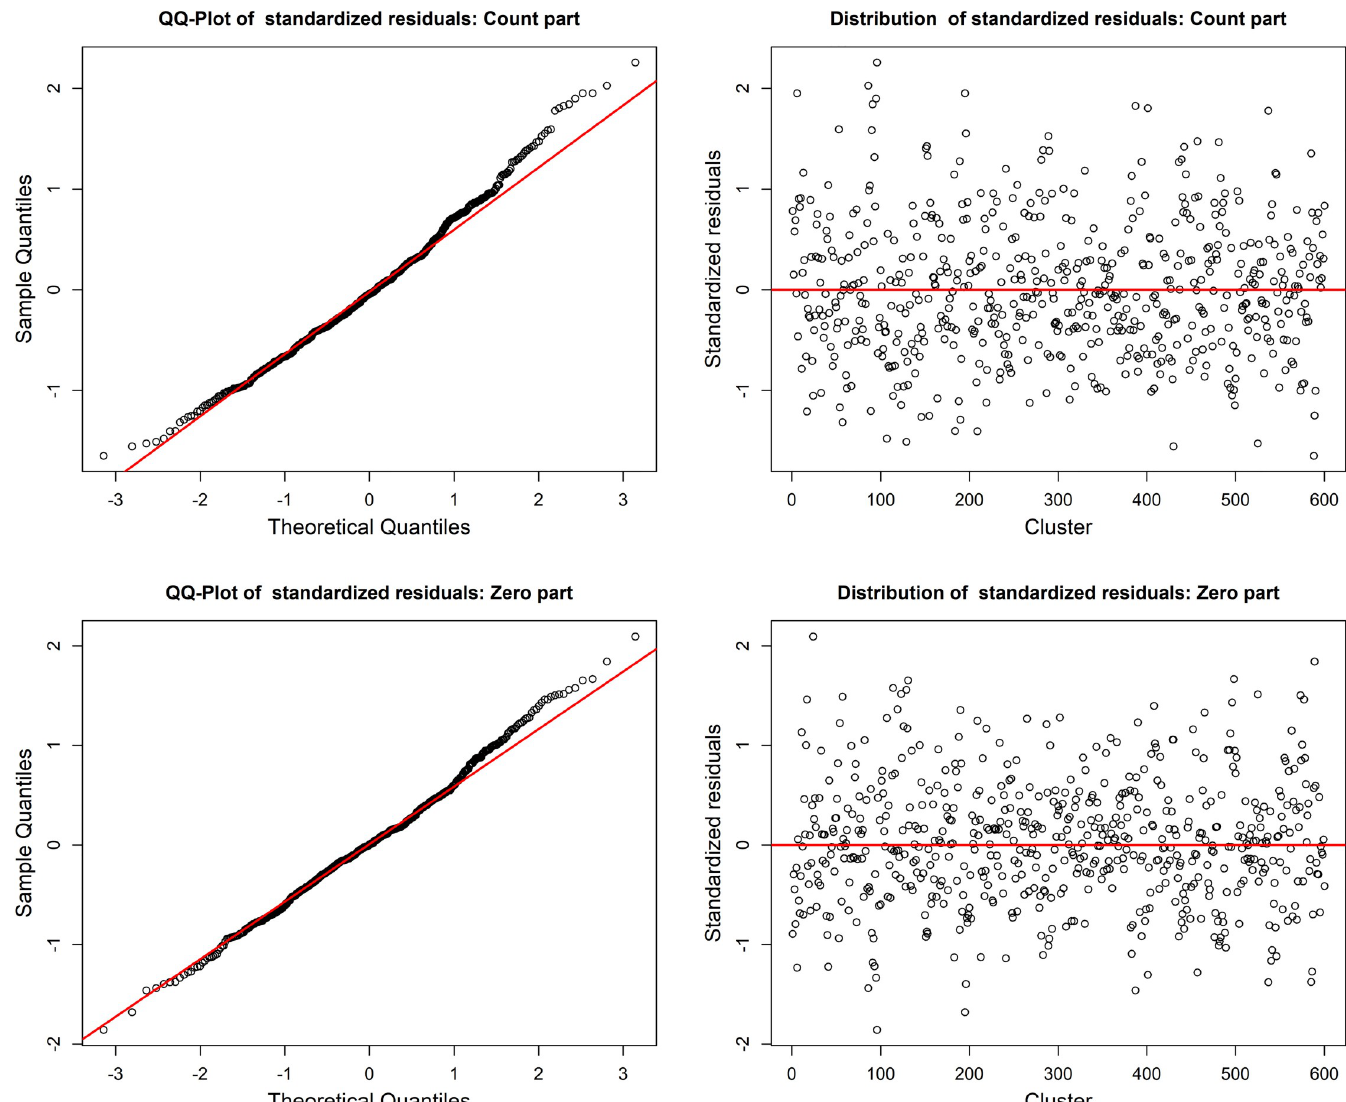
Fig 2. Model diagnostics of both the count and the zero parts of the fitted mixed-effect hurdle negative binomial regression model through Q-Q and distribution plots of the standardized cluster-specific residuals.